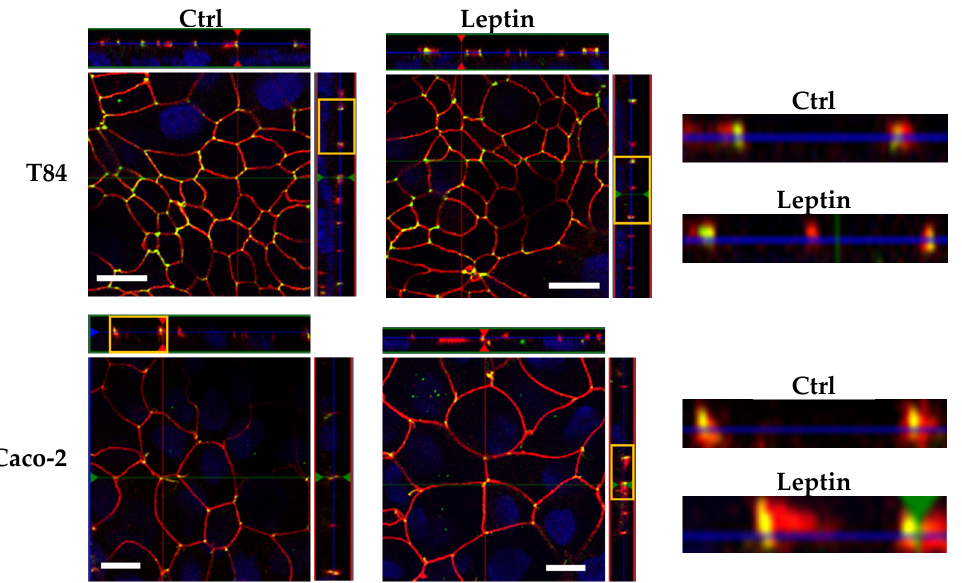
Figure 6. Representative immunofluorescent staining of tricellulin (green) and ZO-1 (red) in human intestinal cell lines. Nuclei were stained using 4’,6-diamidino-2-phenylindole (DAPI) (blue). With the TJ indicator ZO-1, the localization of tricellulin at tricellular TJ (tTJs) are demonstrated. The selected Z-scans (yellow box) are magnified on the right, indicating that there were no localization shifts in the lateral direction. Bars = 10 μ m.